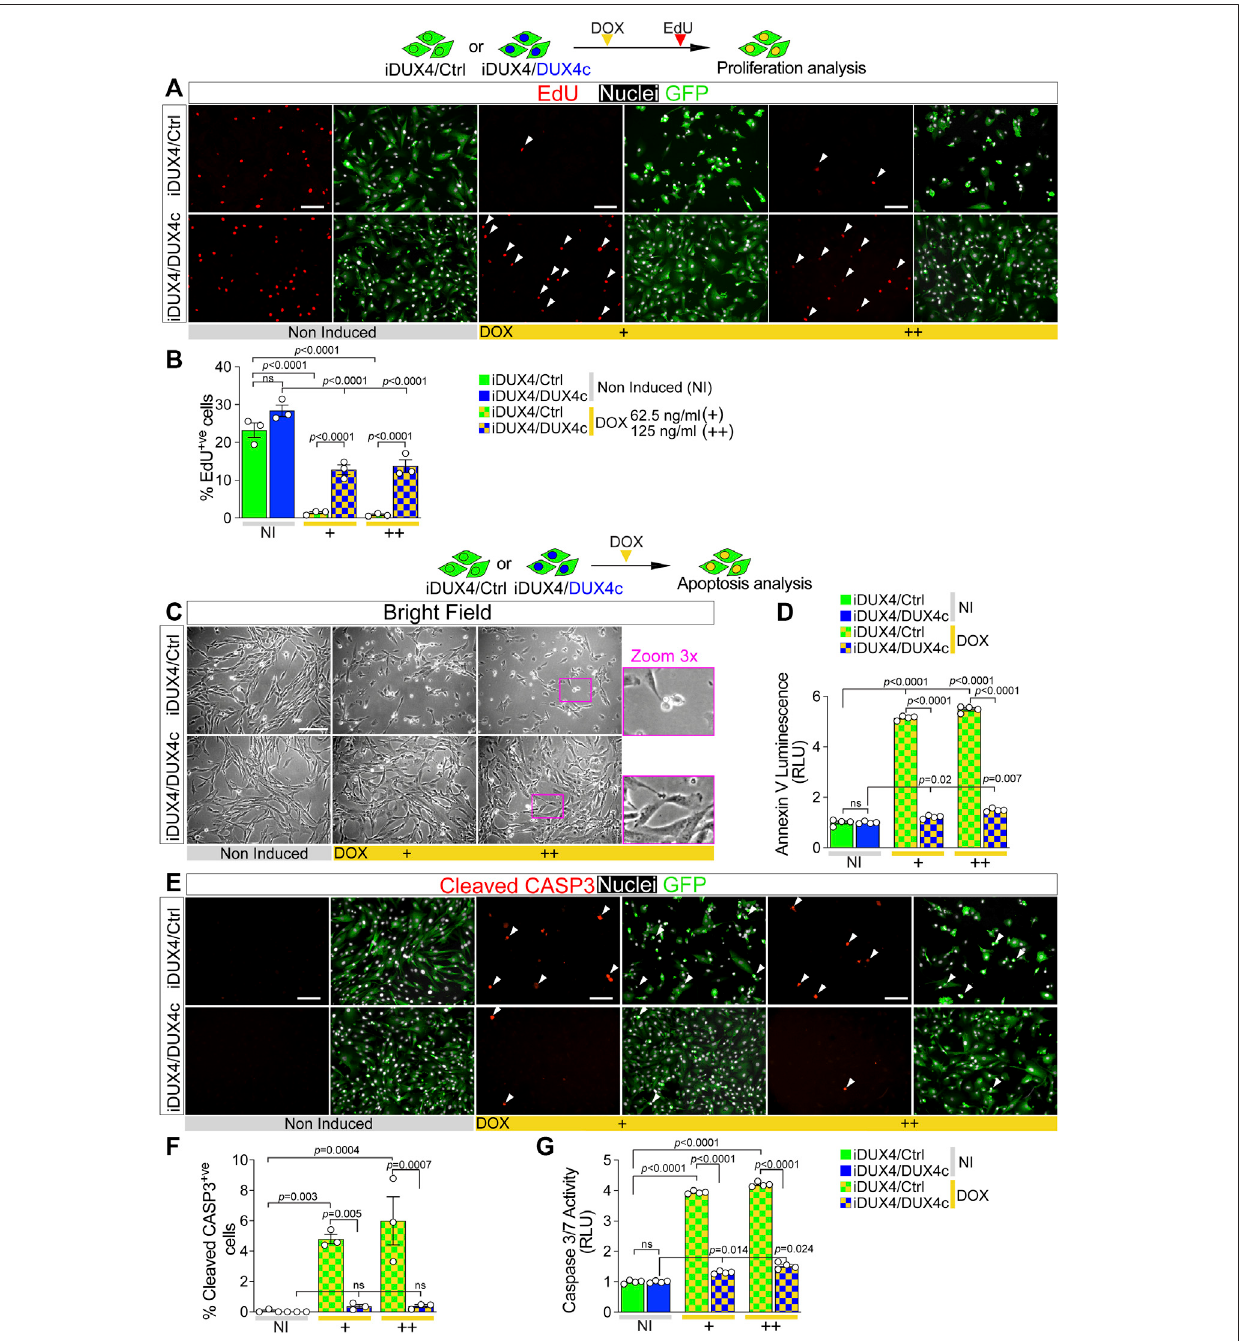
FIGURE2| DUX4cpreventsDUX4 toxicity in proliferating myoblasts. (A) Representative images ofproliferating iDUX4/Ctrl or iDUX4/DUX4c myoblasts when non- induced or induced with either 62.5 ng/ml (+) or 125 ng/ml (++) DOX for 24 h and immunolabelled for GFP (green), with EdU incorporation visualised (red-arrowheads) and nuclei counterstained with DAPI (white). Scale bar equals 100 µm. (B) The percentage of iDUX4/Ctrl or iDUX4/DUX4c myoblasts that incorporated EdU (EdU +ve ) shows that constitutive expression of DUX4c signi fi cantly reduces the anti-proliferative effect of DUX4 compared to RV-ctrl. N = 3 biological replicates, ANOVA, Tukey ’ s posthoc test. (C) Representative images showing that DUX4 up-regulation (24 h of 62.5 ng/ml DOX (+) or 125 ng/ml (++)) results in accumulation of more apoptotic cells in DOX-induced iDUX4/Ctrl than in iDUX4/DUX4c myoblasts, with non-induced (NI) iDUX4 shown for comparison. Scale bar represents 100 µm. (D) Quanti fi cation of apoptosis (Annexin V Luminescence) on iDUX4 myoblasts when non-induced (NI) or after 62.5 ng/ml DOX (+) or 125 ng/ml (++) for 24 h shows signi fi cant induction of apoptosis in iDUX4/Ctrl, but not in iDUX4/DUX4c myoblasts, compared to non-induced (NI) controls. RLU; Relative Luciferase Units reported as fold change to non-induced (NI) iDUX4/Ctrl. N = 4 biological replicates, ANOVA, Tukey ’ s posthoc test. (E) Representative images of proliferating iDUX4/Ctrl and iDUX4/ DUX4cmyoblastsinducedwitheither62.5(+)or125 ng/ml(++)DOXfor24handco-immunolabelledforCleaved-CASPASE3(CASP3)(red)andGFP(green),withDAPI